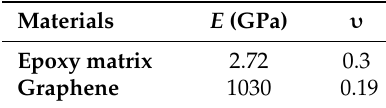
Table 2. Mechanical properties of the constituents.